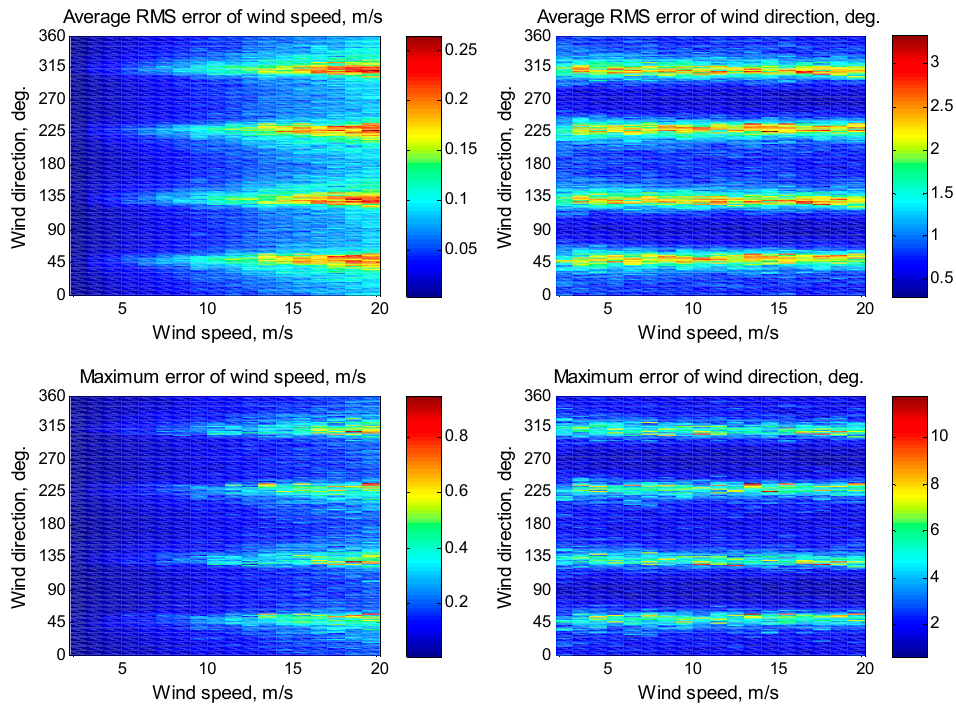
Figure 5. Simulation results for the mounting angle of a beam axis in the horizontal plane of 30° without instrumental noise at wind speeds of 2–20 m/s for the incidence angle of 30° with 5000 averaged NRCS samples for each azimuthal angle.